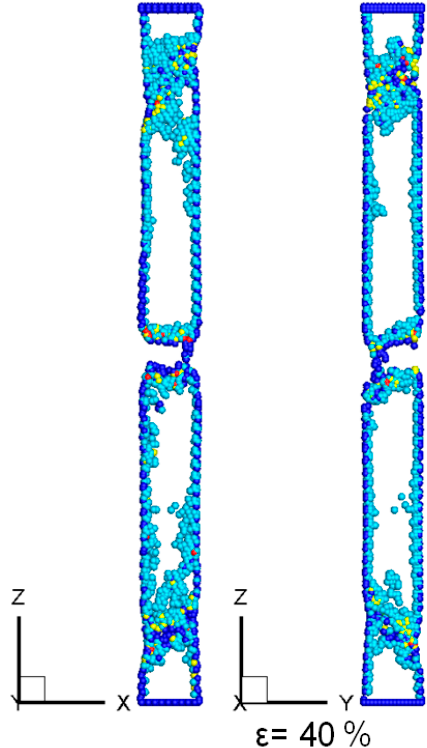
Figure 11. Fracture pattern of (111)-oriented SiNW by tensile stress. (blue: incomplete nanostructure with CN < 4; cyan: CN = 5 meta-stable phase with CN = 5; yellow: Si-II phase with CN = 6; red: high pressure phase with CN > 6).